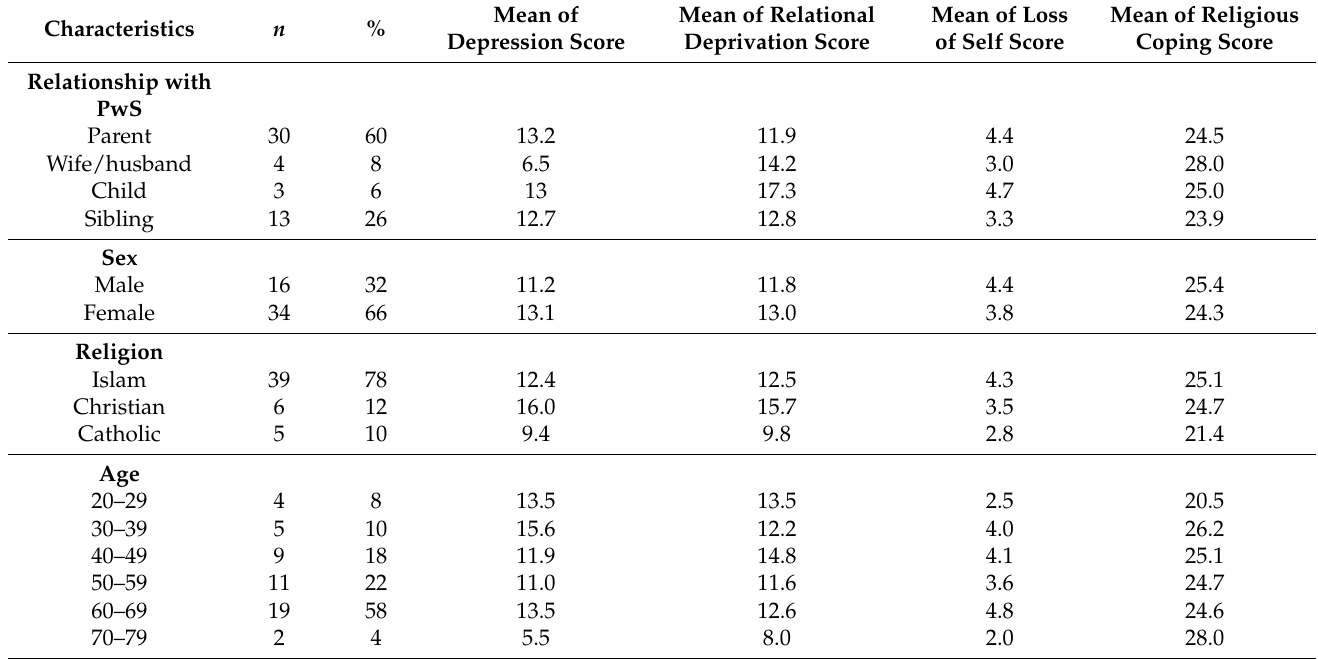
Table 1. Caregiver characteristics ( n = 50). PwS, person with